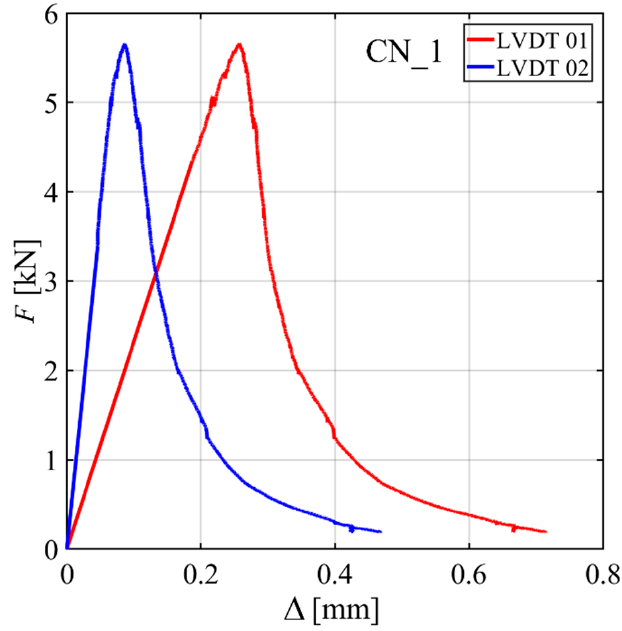
Figure 5. Inconsistency between LVDT readings to measure Δ for CN_1.